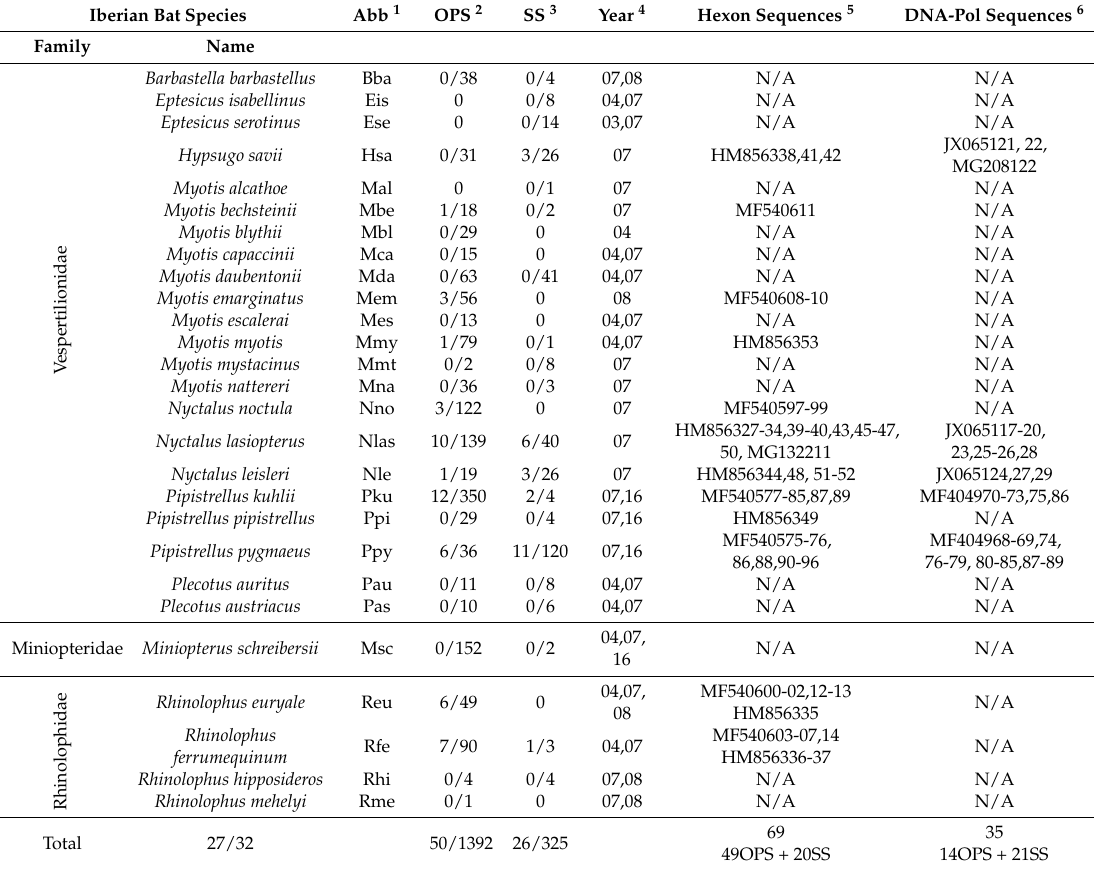
Table 1. Bat species studied, AdV positive results, year of capture and GenBank accession numbers. 5 GenBank Accession number for hexon sequences, 6 GenBank Accession number for DNA polymerase sequences. N/A: Not